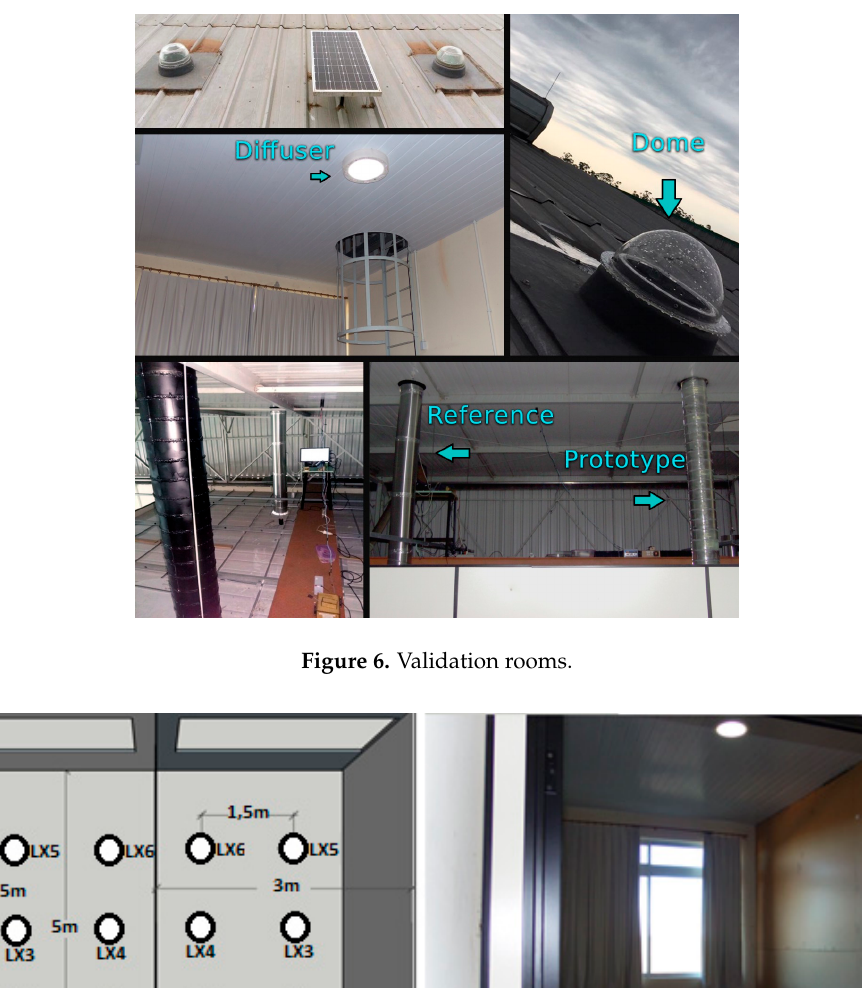
Figure 7. Validation rooms with measuring luxmeters. ( a ) Design; ( b ) Picture.